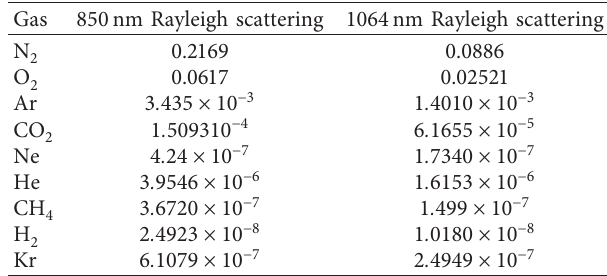
Table 3: Number of gas molecules in the atmosphere. Table 4: Rayleigh scattering values for 850nm and 1064nm.